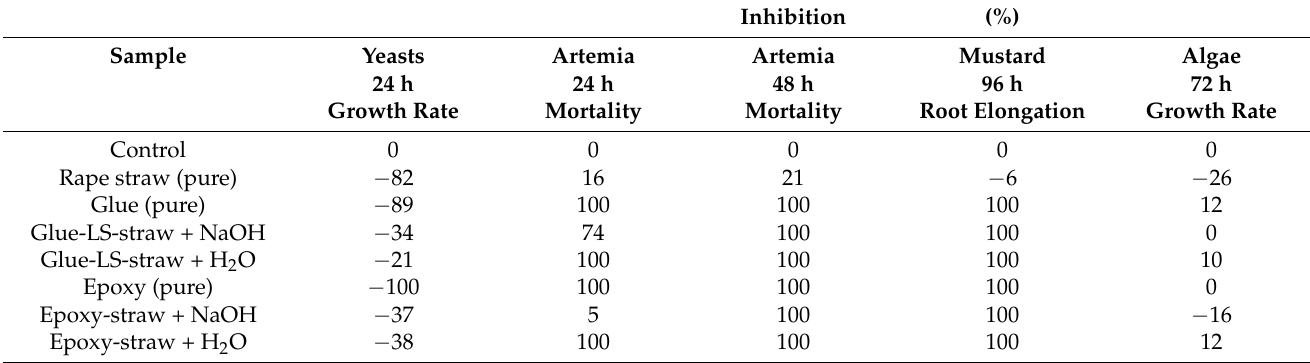
Table 4. Summary results of the ecotoxicological tests (the inhibitions expressed in %tiles in compari- son to